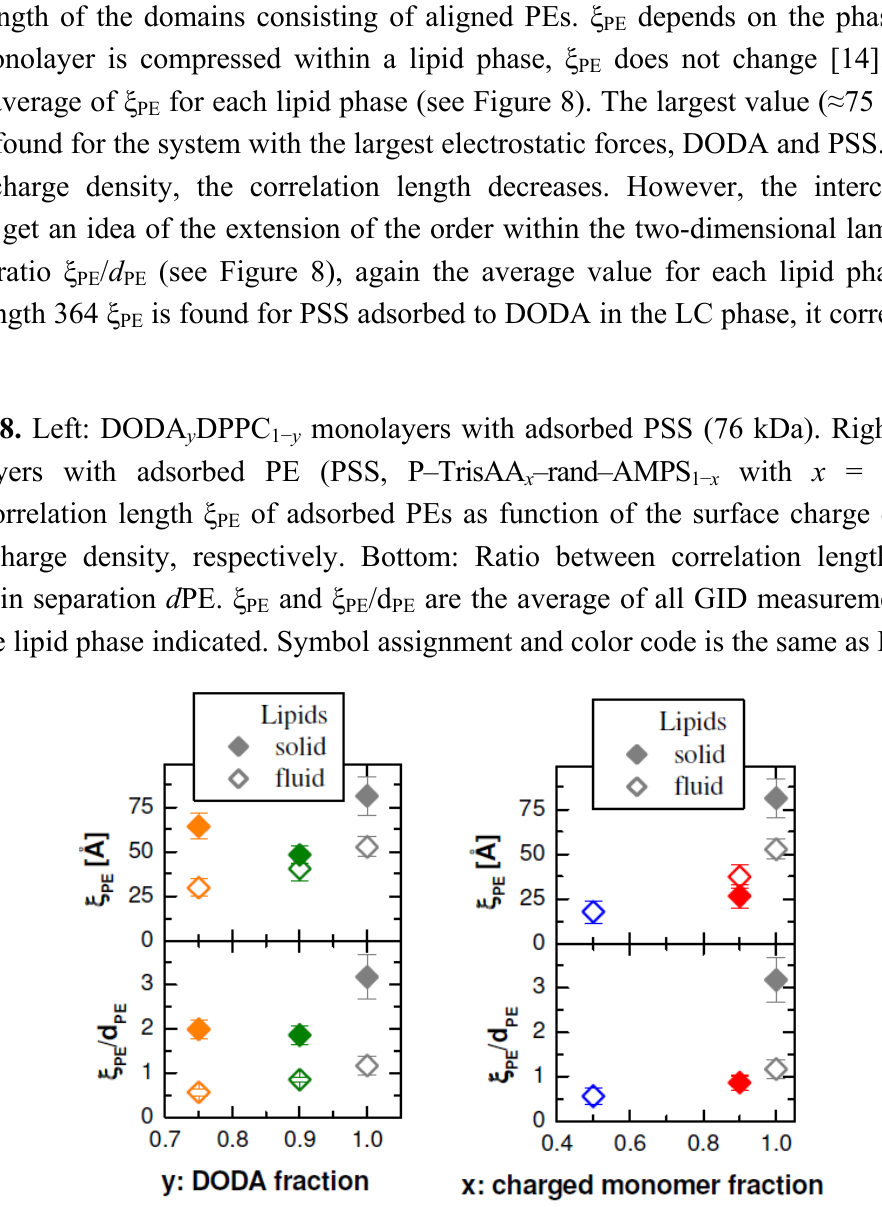
DPPC monolayers with adsorbed PSS (76 kDa). Right: DODA y 1 − y –rand–AMPS with x = 0.9, 0.5). x 1 − x of adsorbed PEs as function of the surface charge density or PE and PE and ξ /d are the average of all GID measurements taken PE PE PE